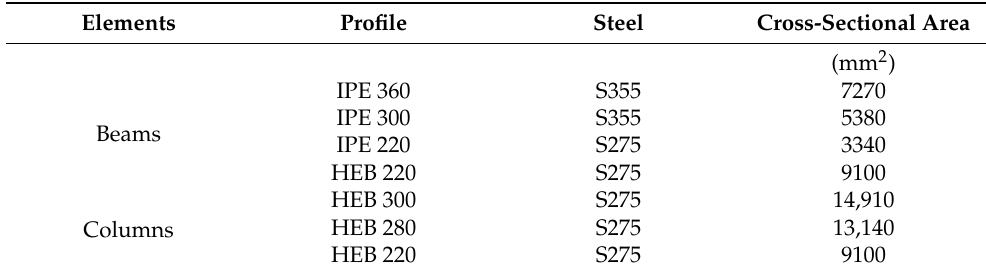
Table 1. Structural assembly cross section